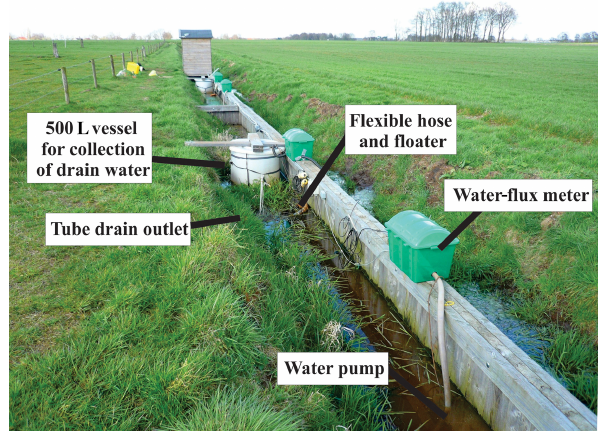
Figure 2. Picture of the complete setup with collector vessels for drain discharge, pumps, and water-flux meters. The shed in the back houses the data acquisition and control